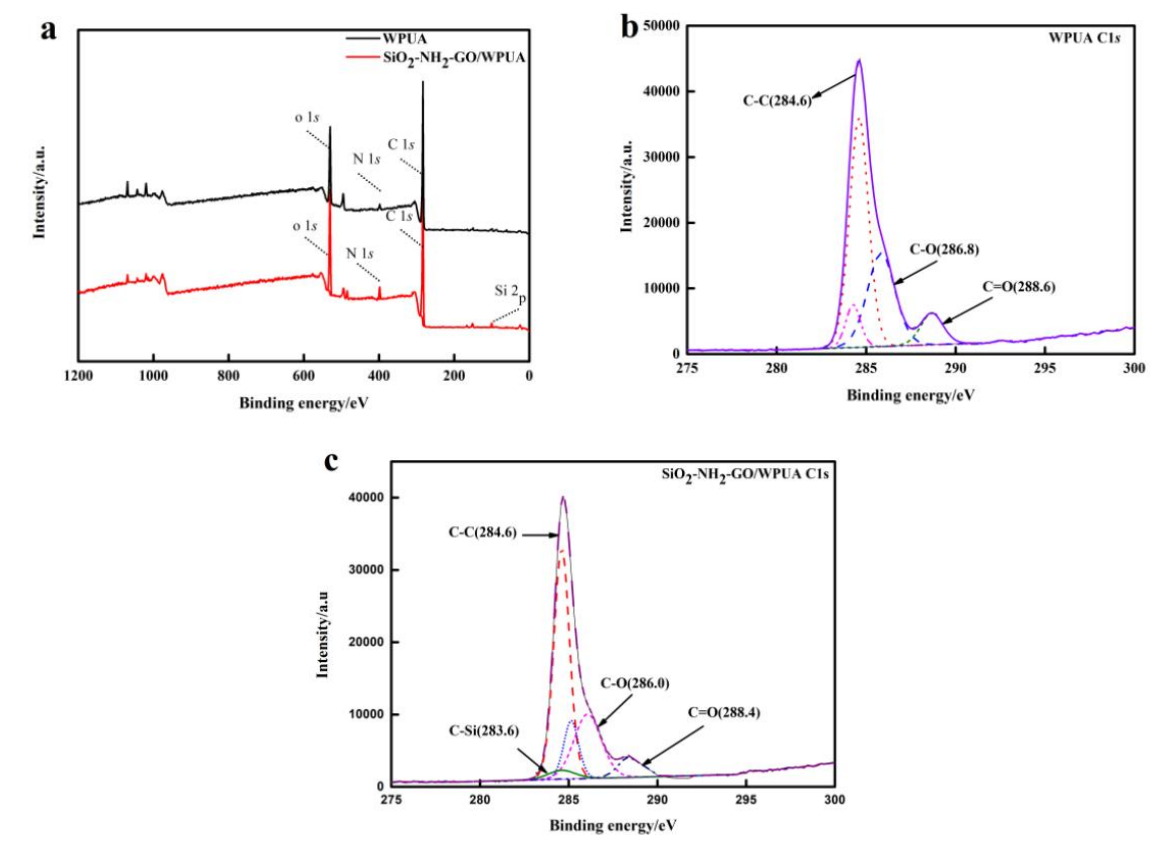
Fig. 7. XPS spectra of WPUA, SiO 2 -NH 2 -GO/WPUA